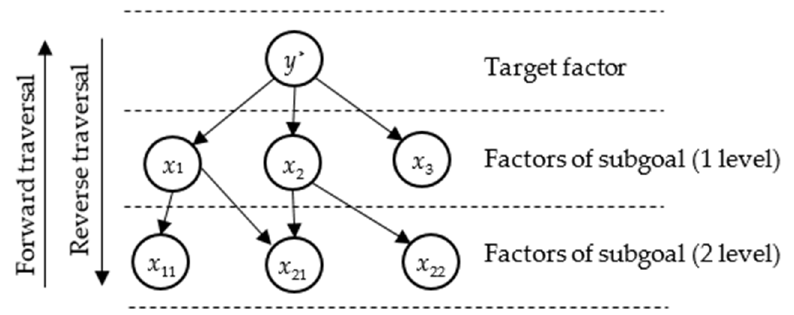
Figure 1. Factor